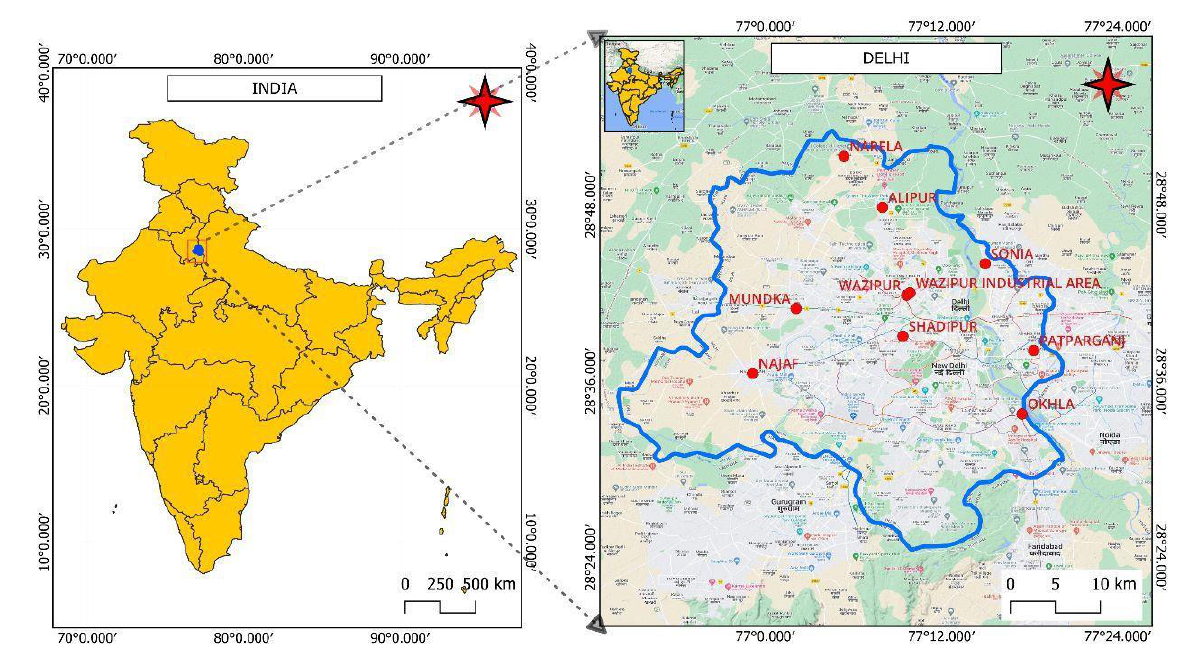
Figure 1. Sampling stations for all monitoring sites at Delhi. Table 1. Different monitoring stations with latitude, longitude, and population census at Delhi. S.